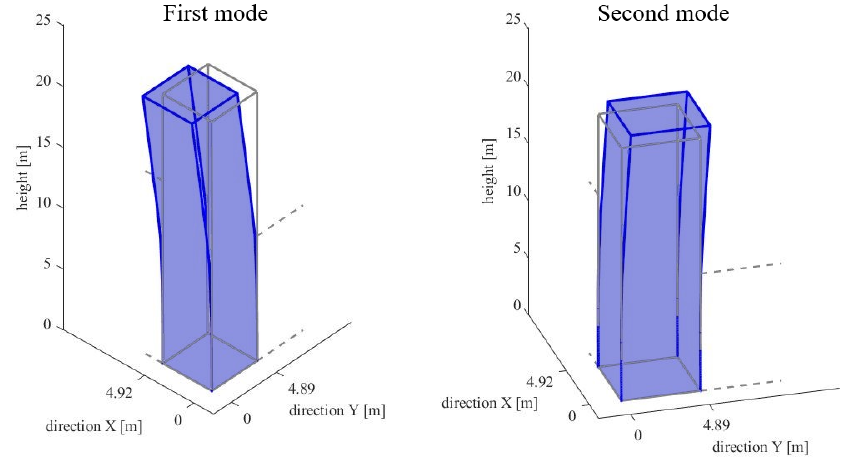
Figure 24. Numerical shapes after the model updating.